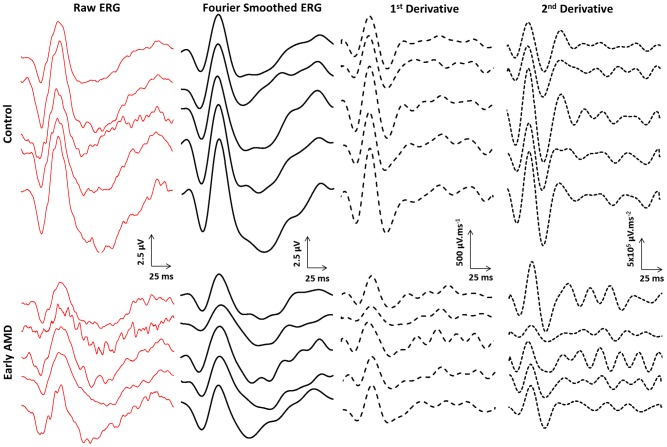
Focal cone ERG waveforms & derivatives.Representative raw, fourier smoothed, 1st derivative and 2nd derivative waveforms of the focal cone ERG are shown for 10 study participants. The waveforms shown were recorded from five healthy participants (TOP) and five early AMD participants (BOTTOM).